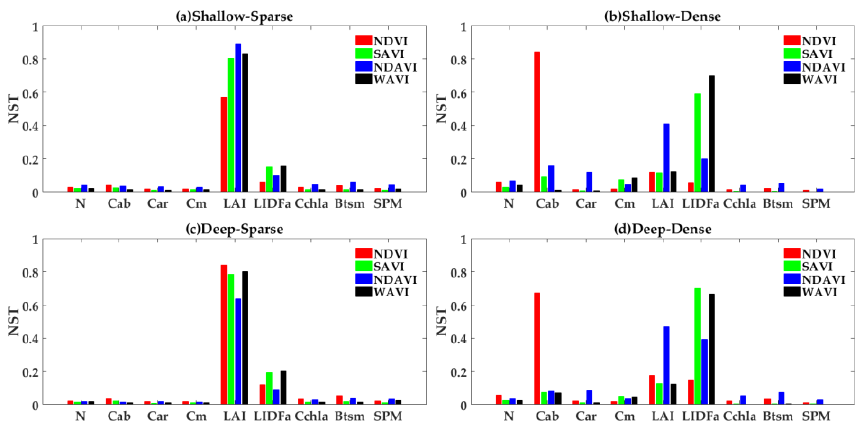
Figure 7. The NST of high sensitivity parameters to vegetation indices for emergent vegetation. ( a ), ( b ), ( c ), ( d ) represent the case of shallow-sparse, shallow-dense, deep-sparse and deep-dense, respectively. In dense cases, the sensitivity of leaf parameters increases clearly, especially for